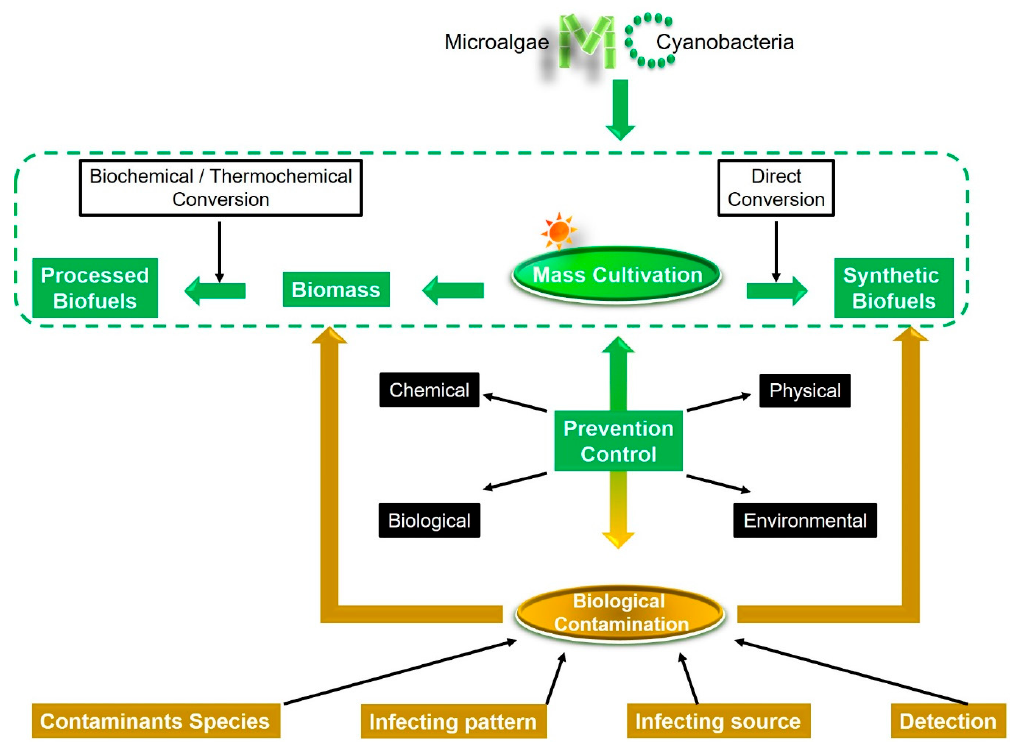
Figure 1. Prevention and control of the biological contamination should be at the top of the priority list for increasing the commercial viability of microalgae- and cyanobacteria-based biofuel